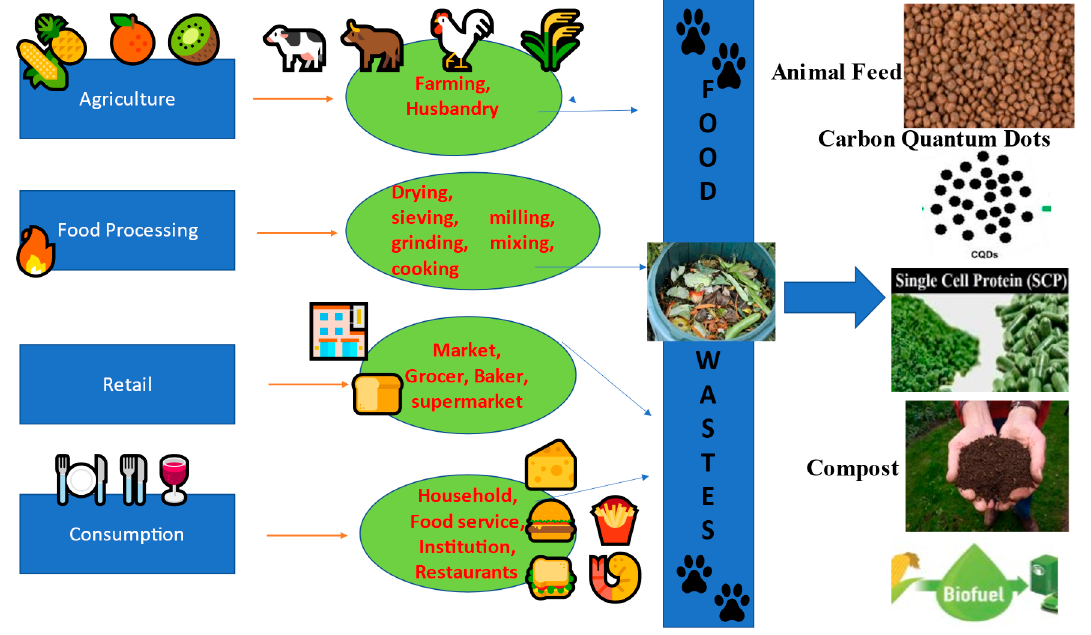
Figure 4. Commercial utilization of food wastes generated from various places and processes. Fig. 4 – Commercial utilization of food wastes generated from various places and Table 1. Various food wastes used as animal processes